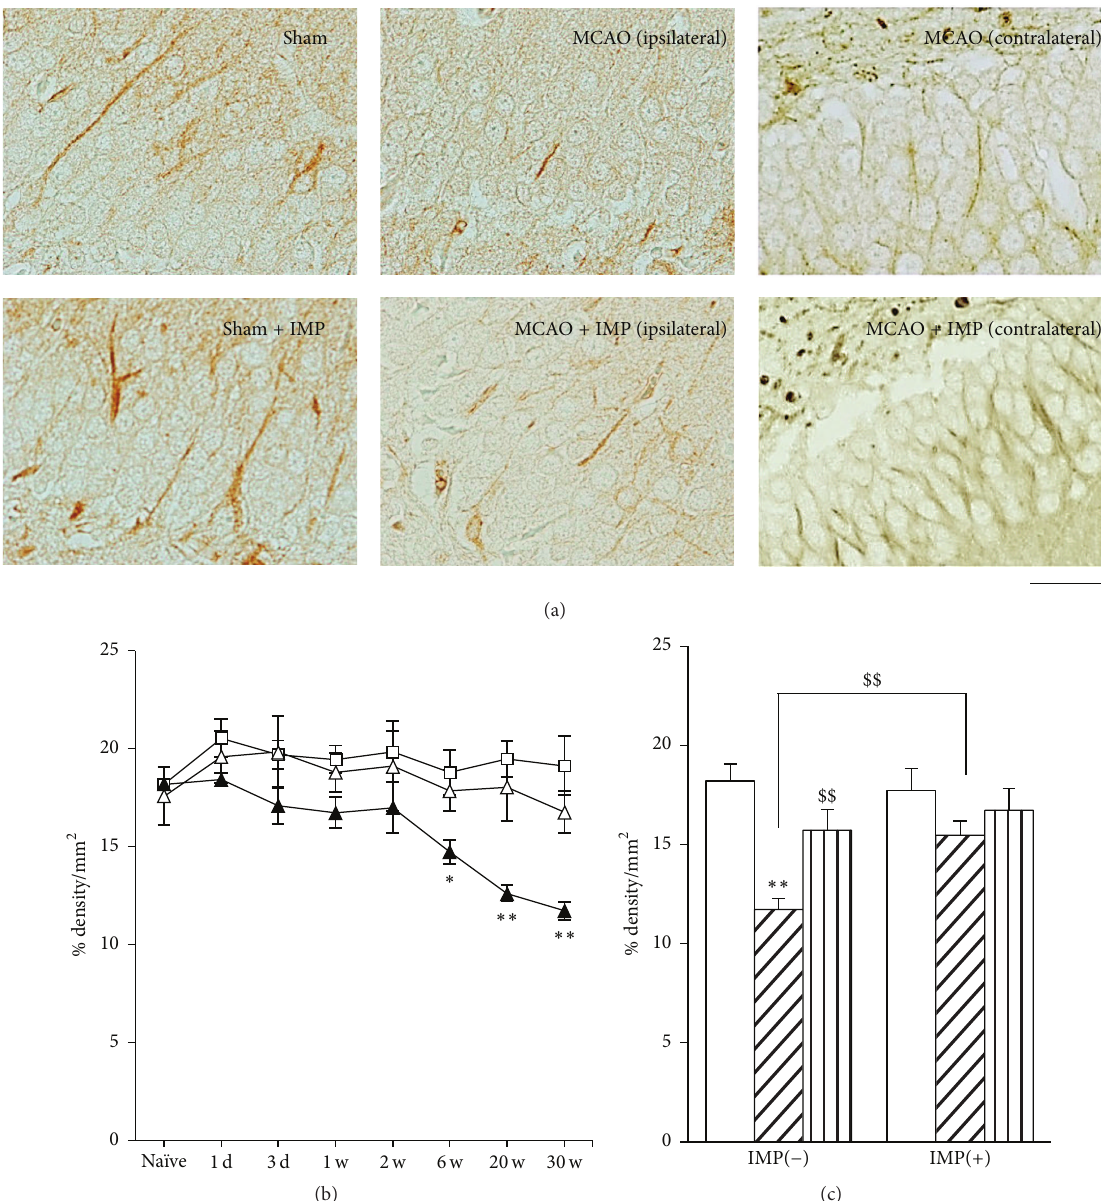
Figure 5: Analysis of 𝛽 III-tubulin immunopositive areas in GCL. (a) Typical images of the slices taken at 30 weeks after MCAO. Scale bar indicates30 𝜇 m.(b)Timecoursechangesof 𝛽 III-tubulinimmunopositiveareasafterMCAOinGCL.Symbolsusedareasfollows:opensquare, sham; closed triangle, ipsilateral MCAO; open triangle, contralateral MCAO. Statistical significance was evaluated with two-way ANOVA = 3.06 ; 𝐹 = 19.6 ; 𝐹 = 1.17 ; ∗ 𝑃 < 0.05 and ∗∗ 𝑃 < 0.01 versus followed by Tukey-Kramer test at each time point ( 𝐹 ( ( group )2 ( time ∗ group )14,96 time )7 sham). (c) Analysis of the effect of IMP on 𝛽 III-tubulin immunopositive areas at 30 weeks after MCAO. Vehicle [IMP( − )] or 20 mg/kg/day of IMP for 29 weeks [IMP(+)] from 1 week after the surgical operation was administered. Statistical significance was evaluated with one-way ANOVA followed by Tukey-Kramer test ( 𝐹 5,24 = 6.05 ; ∗∗ 𝑃 < 0.01 versus sham [IMP( − )]; 𝑁 = 5 /group). Unpaired 𝑡 -test was performed with ipsilateral MCAO [IMP( − )] versus contralateral MCAO [IMP( − )] ( 𝑡 = 3.41 , $$ 𝑃 < 0.01 ) or versus ipsilateral MCAO [IMP(+)] ( 𝑡 = 4.12 , $$ 𝑃 < 0.01